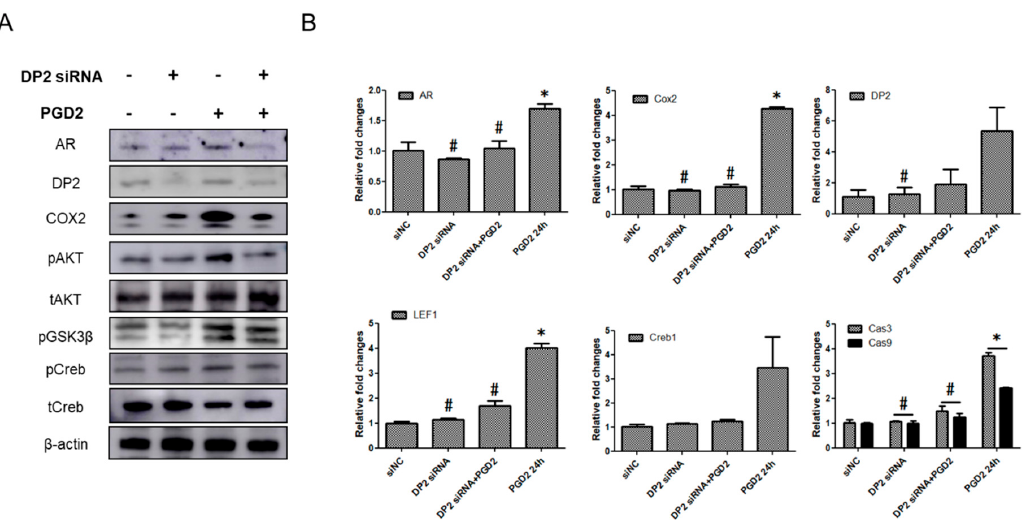
Figure 5. Knockdown of DP2 suppress AR related genes and AKT signal. After transfection with negative control (siNC) or DP2 siRNA, and then treated with PGD2 (200 nM) for 5 h. The protein levels of AR, DP2, COX2, and AKT/GSK3 β /Creb phosphorylation was measured using western blot analysis ( A ). After transfection with siNA or DP2 siRNA for 24 h, and then treated with PGD2 (200 nM) for 24 h. The mRNA expression of AR, DP2, COX2, LEF1, Creb, and caspases (-3, and -9) was measured by qRT-PCR ( B ). β -actin served as a loading control for protein normalization. GAPDH was used as an internal control for mRNA normalization. The results are expressed as the mean ± SD of three independent experiments. * p < 0.05 compared with the siNC (siRNA negative control), # p < 0.05 compared with PGD2.